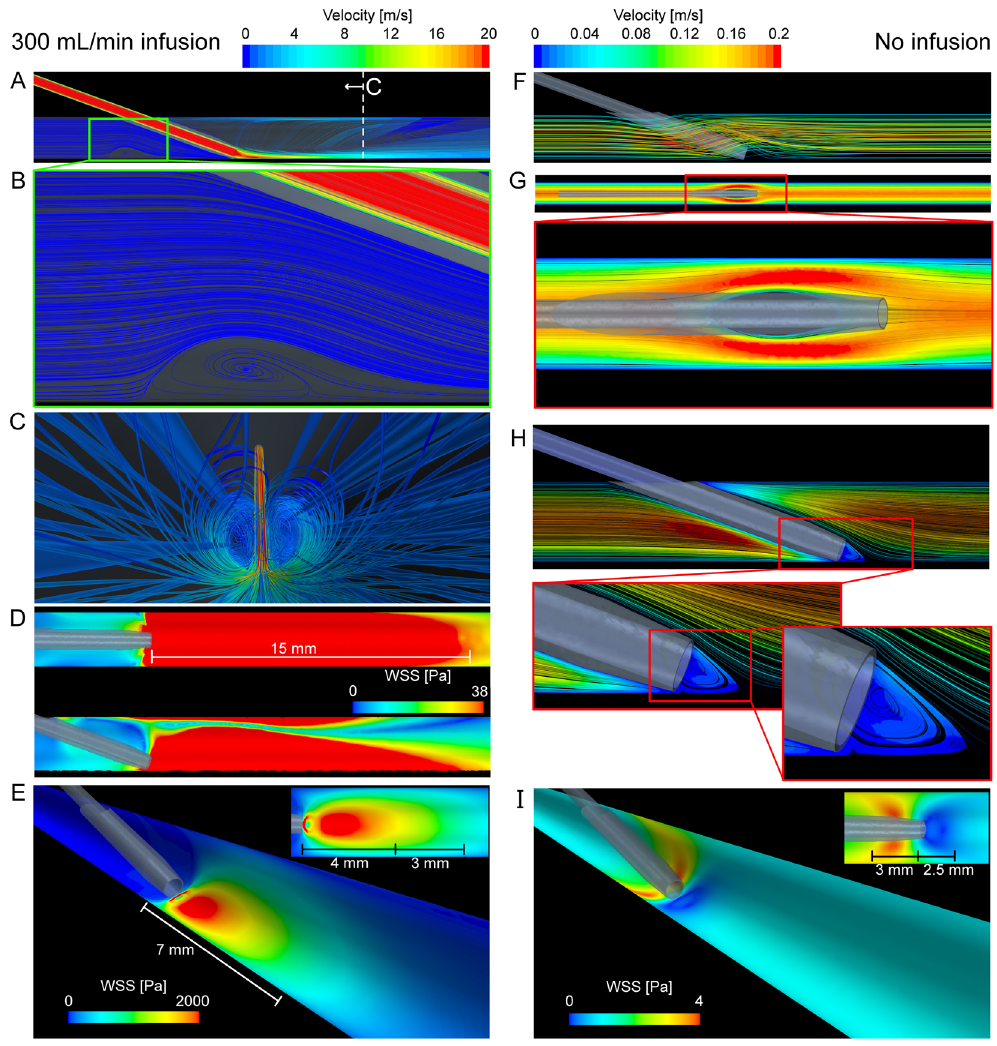
Figure 2. Resulting velocity streamlines and wall shear stress (WSS) due to the infusion of saline into the vein (left column) and the scenario without infusion (right column). Velocity streamlines at 300 mL/min saline infusion ( A ) show the low velocity recirculation zone ( B ) behind the catheter tip, and the internal vein view ( C ) shows the streamlines of infused saline. The view show in ( C ) is indicated in ( A ). The region of WSS > 38 Pa ( D , top and side views shown) is an area of likely significant endothelial damage and in this scenario the WSS reaches a maximum of approximately 3800 Pa. The region of WSS > 38 Pa extends 15 mm from the catheter tip. ( E ) Contours of WSS scaled to approximately half the maximum WSS. The distance of these high WSS regions is also shown. The insert shows the view from above. Velocity streamlines ( F ) and contours ( G , midplane of vein) of blood without saline infusion show the hemodynamics around the catheter that creates a distinct localized low velocity recirculation zone at the catheter tip ( H ). The WSS shows that without the infusion of saline, the WSS is highest behind the catheter tip and low at the catheter entrance ( I ). The distance from the catheter tip is also shown in ( I ) and the insert shows the view from